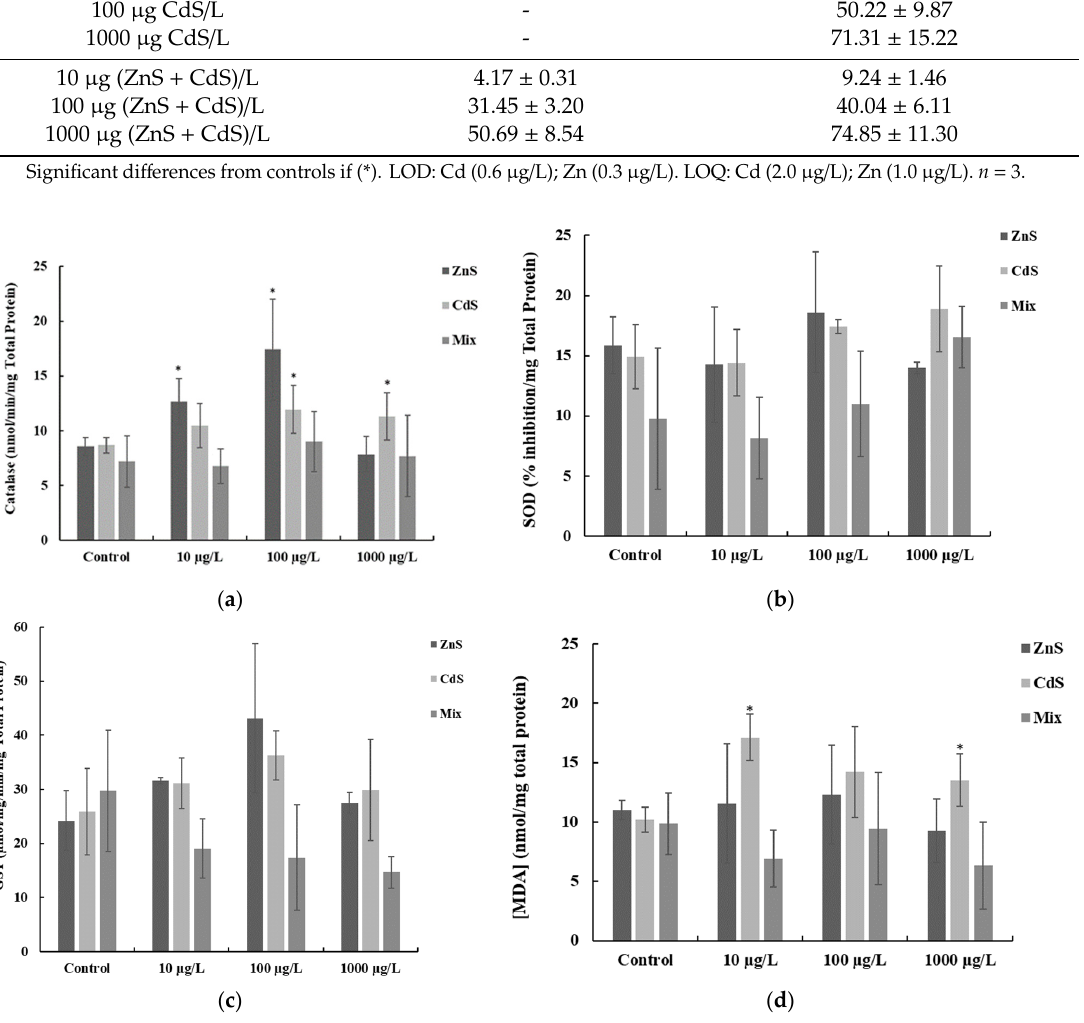
Figure 2. Antioxidant enzymes activities (mean ± SD): ( a ) CAT, ( b ) SOD ( c ) GST; and ( d ) Lipid peroxidation (MDA content) in zebrafish exposed to different concentrations of QDs, alone and combined (Mix). Asterisk means significant differences ( p < 0.05) in comparison to the respective controls.